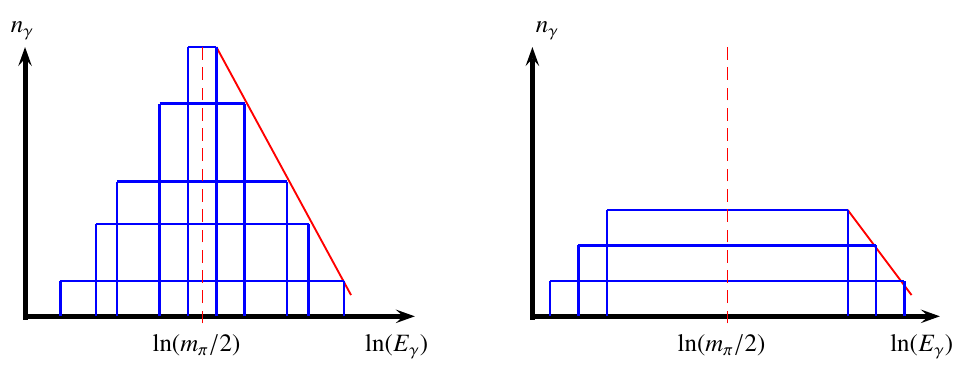
Figure 2. The photon spectrum n (cid:13) = d N = d E (cid:13) produced in (cid:25) 0 decays as function of ln( E (cid:13) ) for pp (left panel) and for p (cid:13) (right panel)